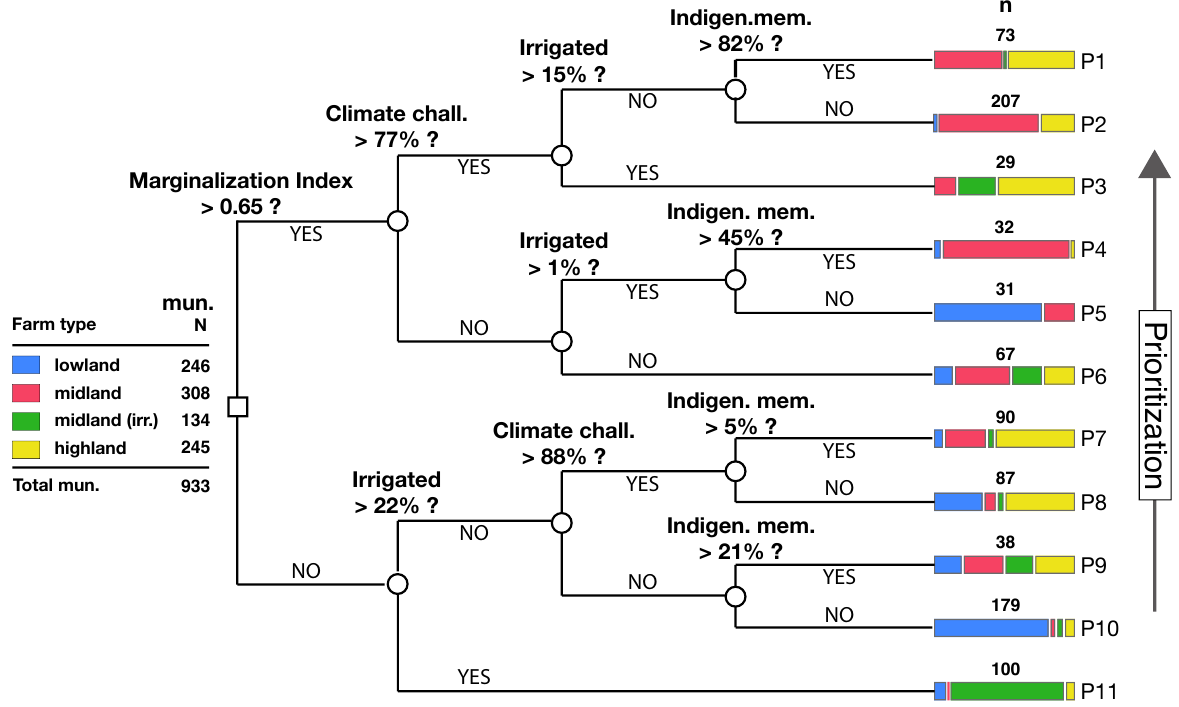
Figure 4. Decision tree (CART) model illustrating the recursive partitioning (binary) of municipalities into ranked priority subgroups for targeting. Splitting criteria reflect four priority objectives of Mexico’s National Water Program. Splitting order and decision threshold values (Yes/No) follow sequential best fit (maximum separation between groups). Pathways to priority subgroups are ordered vertically to reflect priority